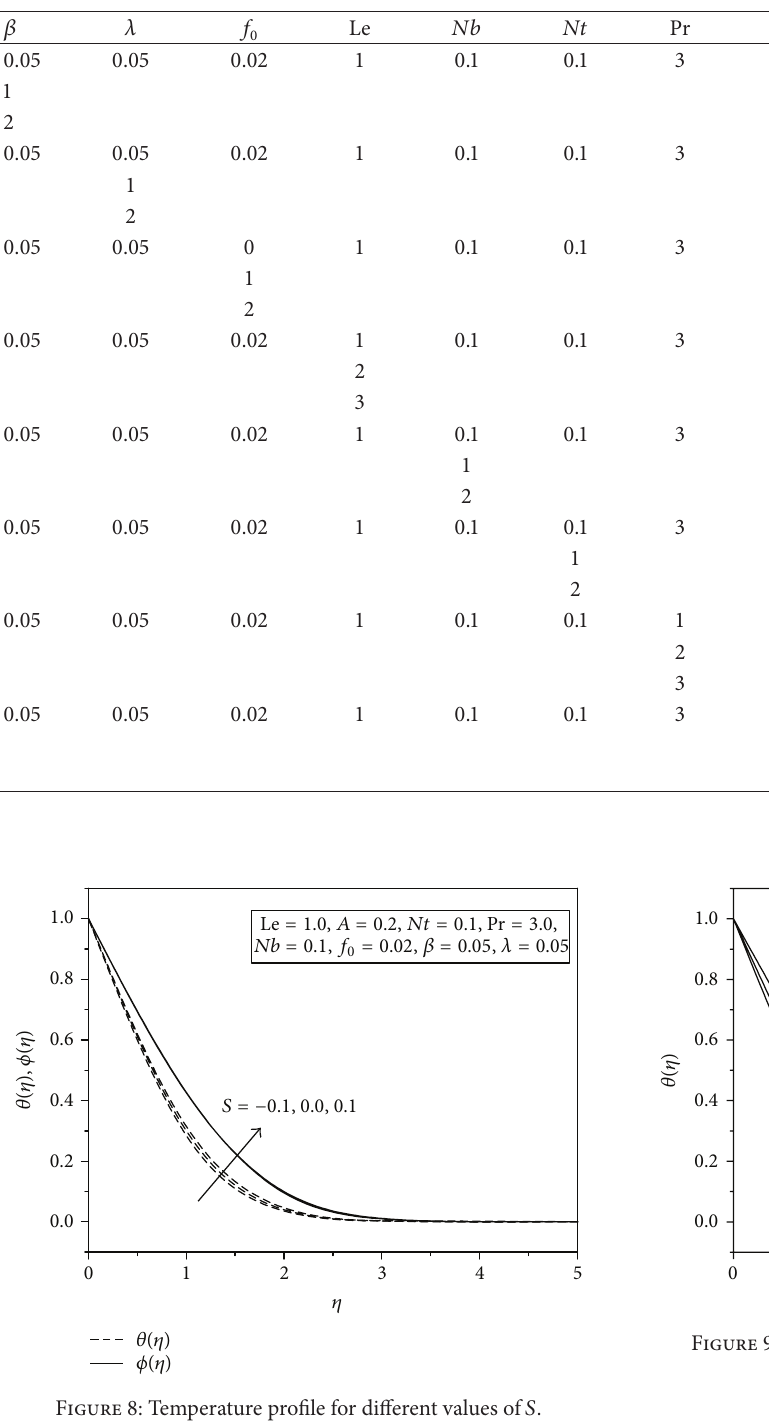
Table 3: Values of skin friction coefficient −𝑓 󸀠󸀠 (0) , Nusselt number −𝜃 󸀠 (0) , and Sherwood number −𝜙 󸀠 (0) for different values of the physical parameters with 𝐴 = 0.2 .